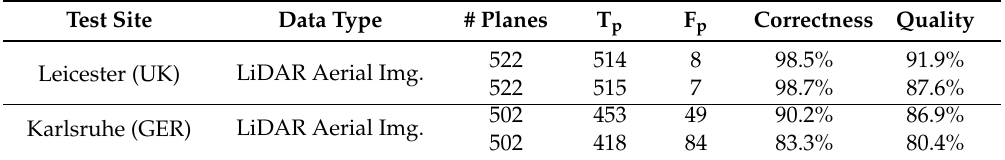
Table 4. Correctness and quality of roof plane extraction for the Leicester and Karlsruhe test site.